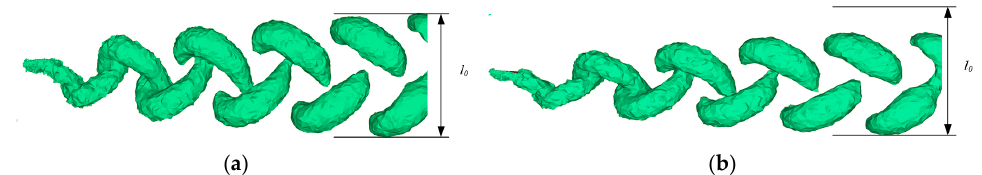
Figure 13. Three-dimensional vortex pattern in the wake of the NACA foil: ( a ) γ = 20°; ( b ) γ = − 20°.